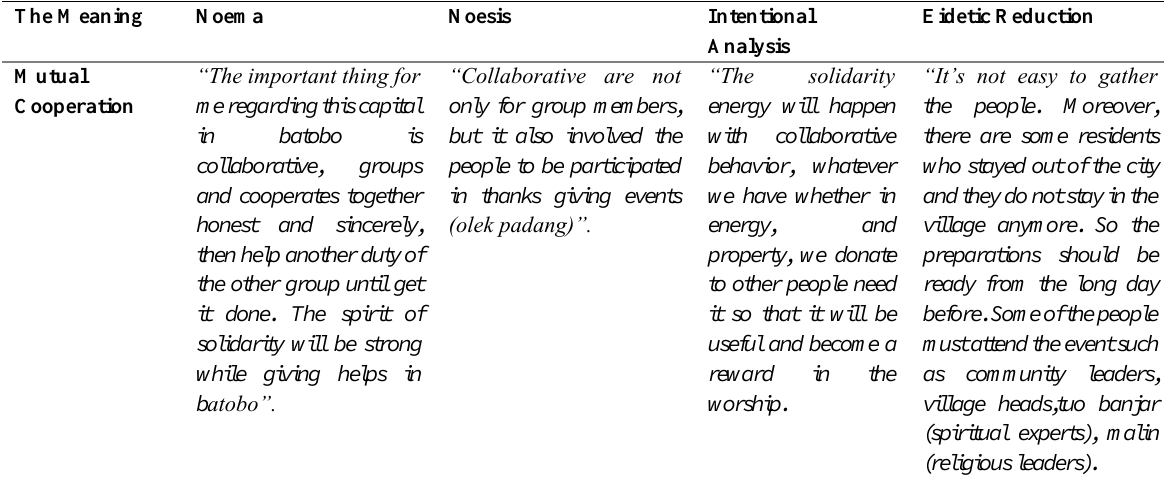
Table 2: Practioners Meaning of